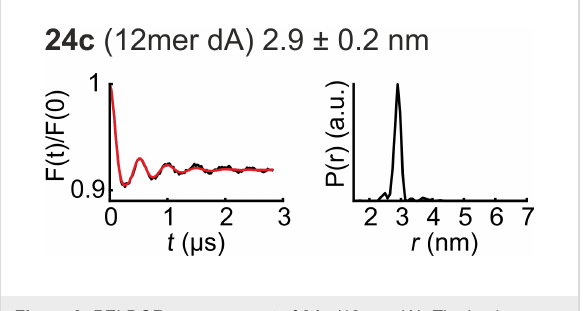
Figure 3: PELDOR measurement of 24c (12mer dA). The back- ground-corrected time trace (original time trace in Supporting Informa- tion File 1, Figure S21) was fitted with Tikhonov regularization (red) with DeerAnalysis15 [48]. The distance distribution shows a well- defined distance of 2.9 ± 0.2 nm.